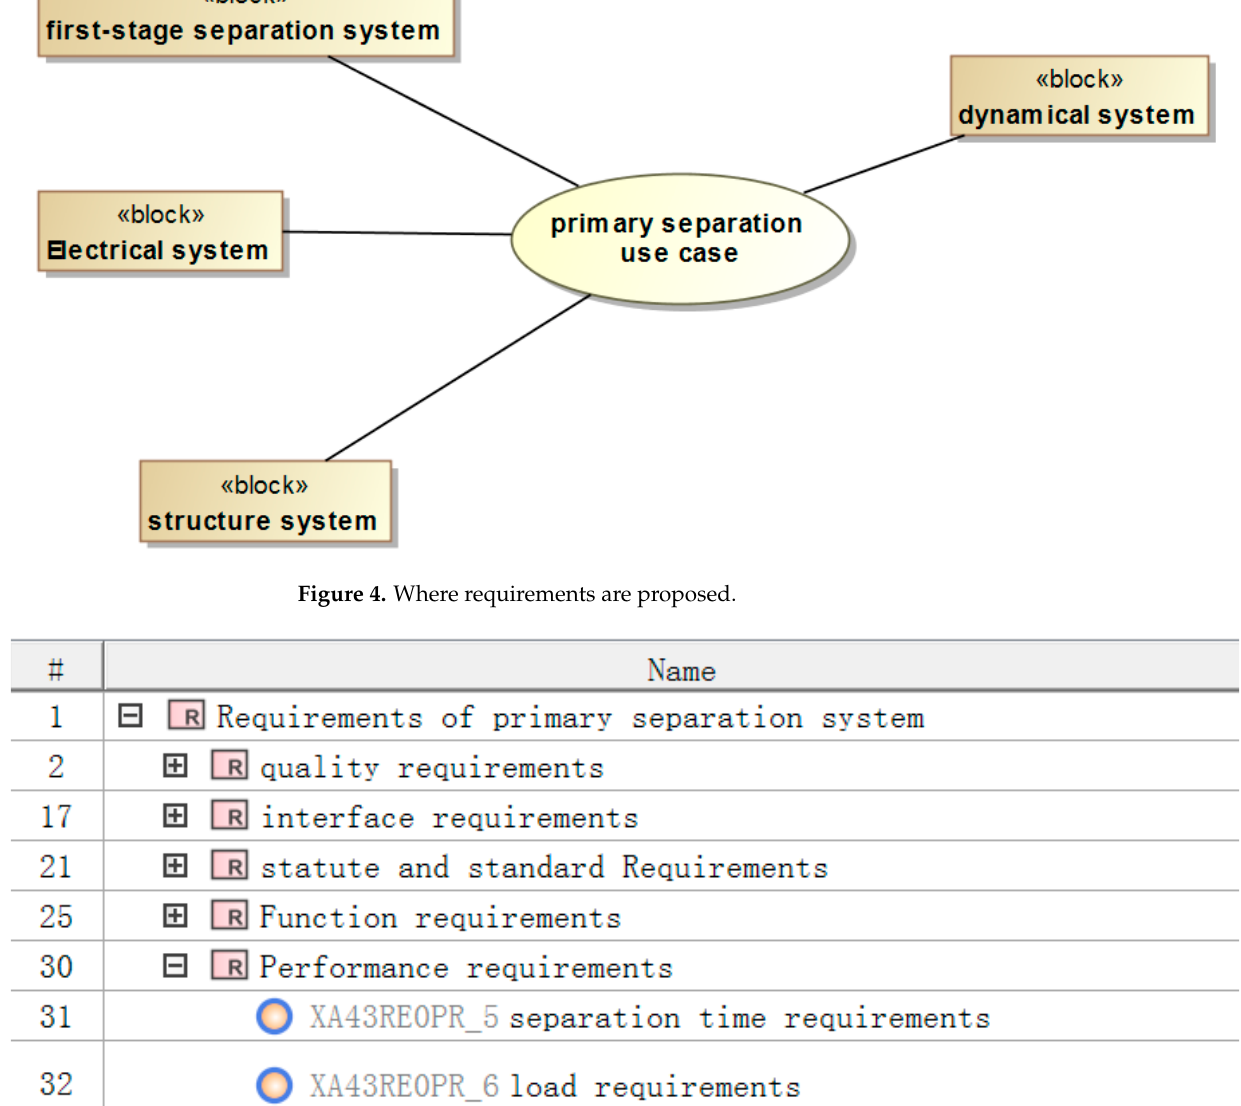
Figure 3. When requirements are proposed.